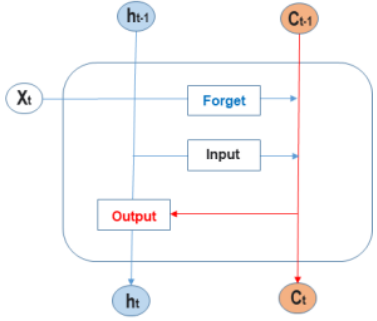
Figure 1 . The basic structure of LSTM. Figure 1. The basic structure of